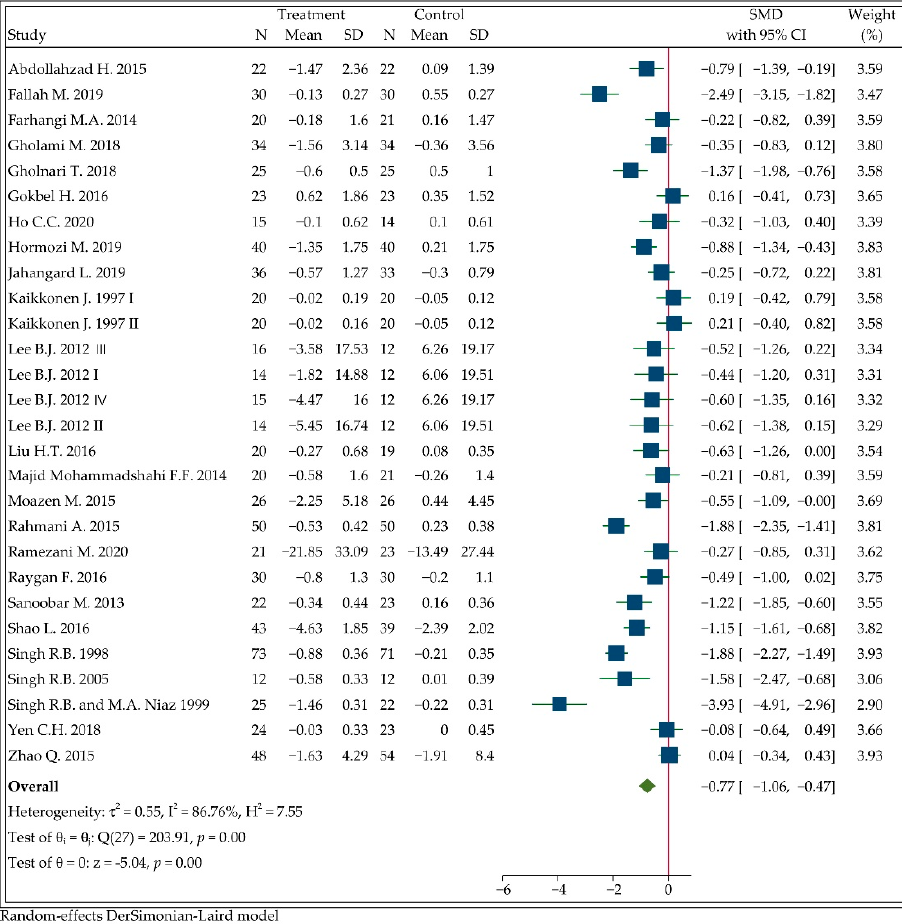
Figure 3. Forest plot of the meta-analysis on the effect of CoQ10 supplementation on net changes of MDA. Table 3. Subgroup analyses of CoQ10 supplementation on